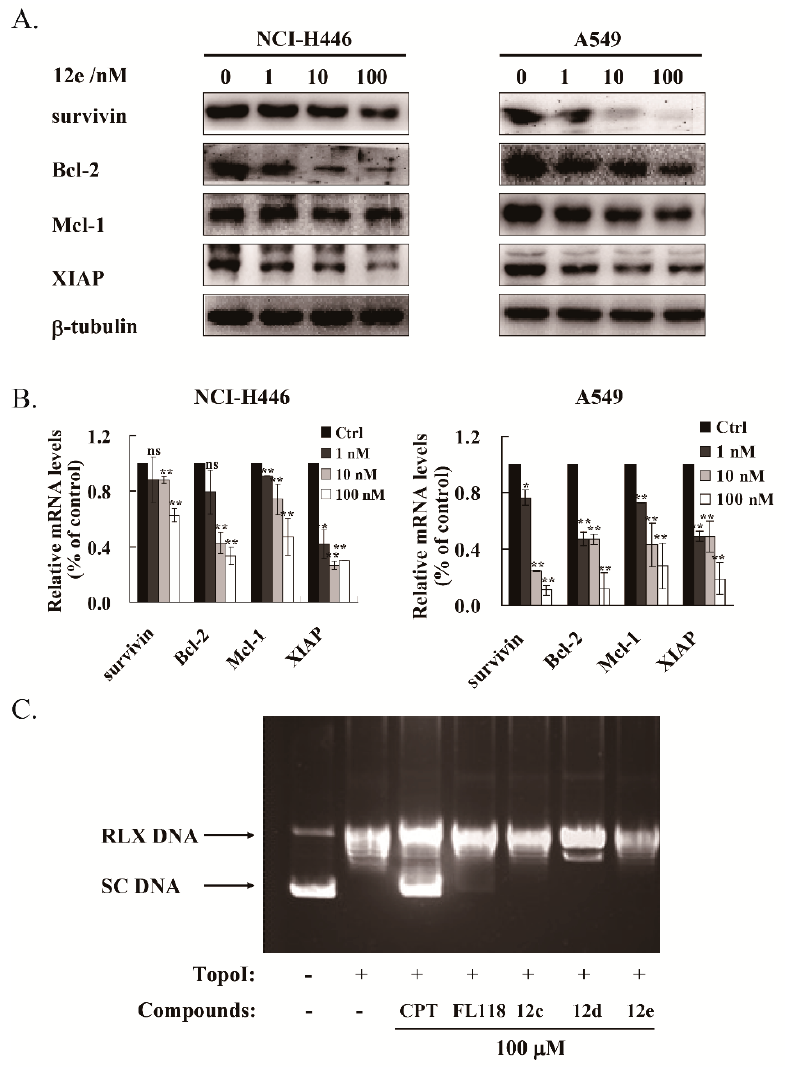
Figure 5. 12e treatment reduces the transcription and expression of multiple anti-apoptotic proteins in lung cancer cell lines. ( A ) NCI-H446 and A549 cells were treated with 12e (0–100 nM) for 24 h, the expression levels of survivin, Bcl-2, Mcl-1 and XIAP were detected by western blotting. β -tubulin was chosen as the internal control. ( B ) Upon exposure to 12e (0–100 nM) for 24 h, the relative mRNA level of survivin, Bcl-2, Mcl-1 and XIAP in NCI-H446 and A549 cells were determined using RT-PCR technique. * p < 0.05, ** p < 0.01 vs. control. ( C ) Topo I- Mediated relaxation of pBR322 DNA Assay with or without indicated compounds. The pBR322 DNA was presented as supercoiled (SC) without treatment of Topo I, and relaxed (RLX) with the treatment of Topo I. CPT was used as a positive control.